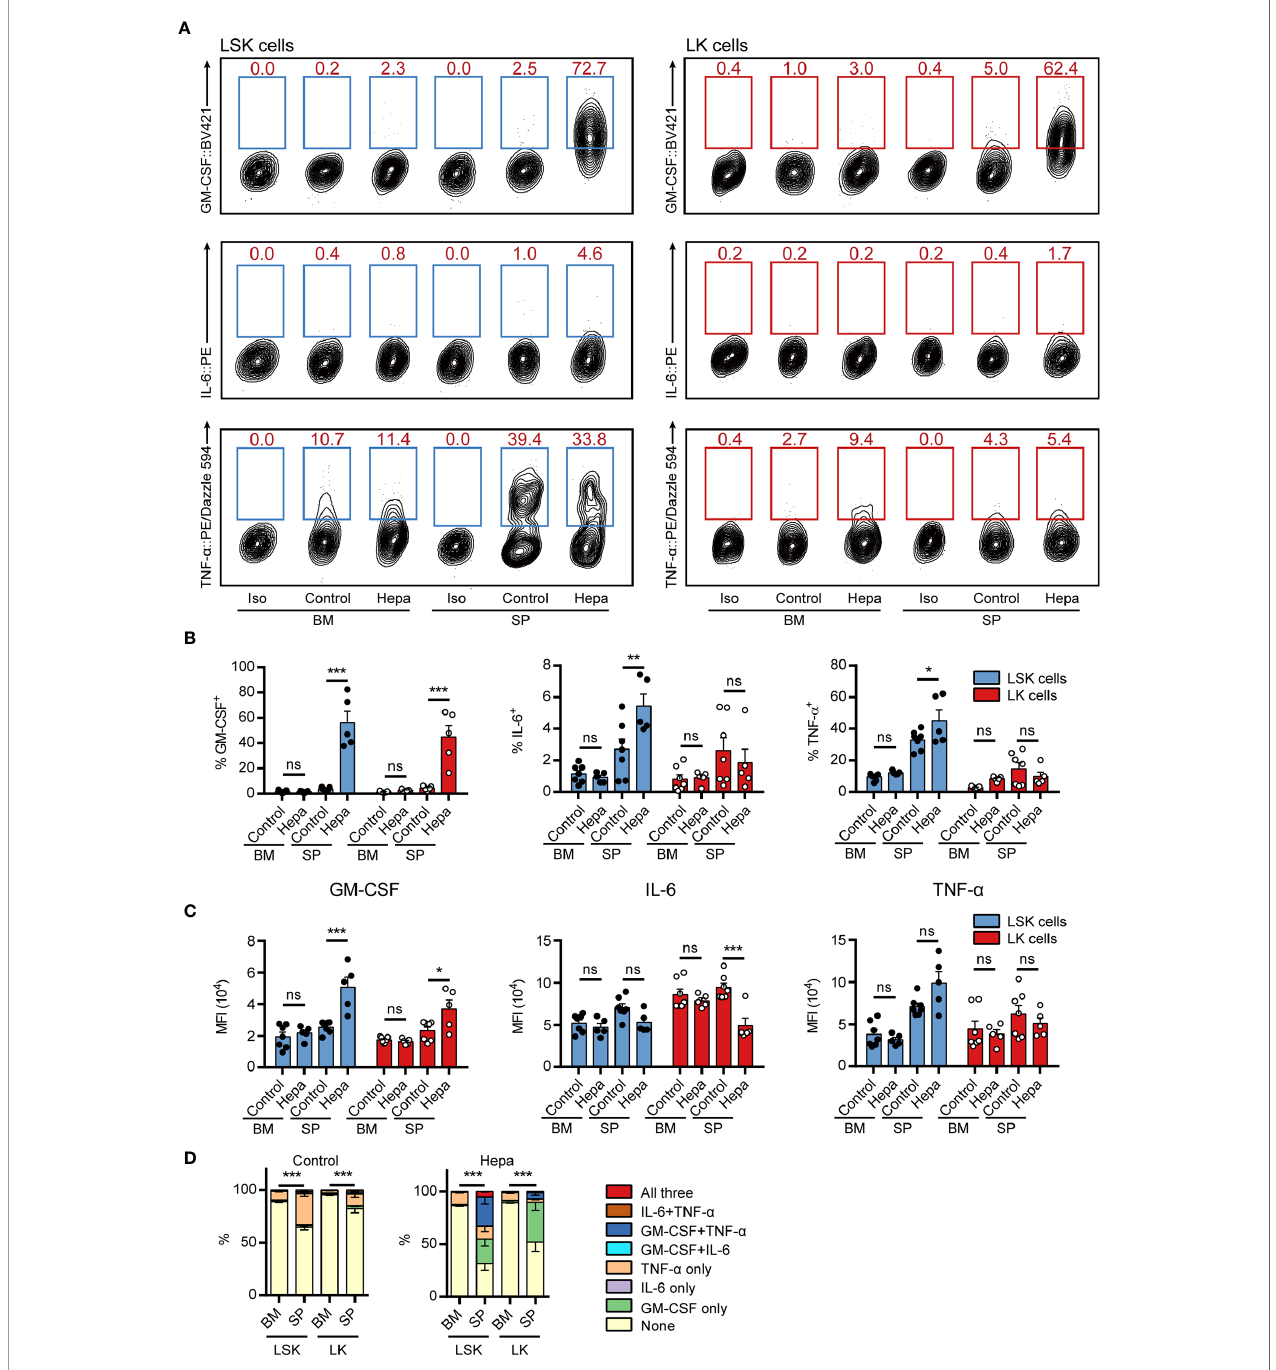
FIGURE 3 | Measuring intracellular cytokine levels in freshly isolated HSPCs from hepatoma-bearing mice with restimulation II. (A) Representative fl ow cytometric analysis of intracellular GM-CSF, IL-6 and TNF- a in freshly isolated LSK cells (left) and LK cells (right) from the BM and spleen of control or Hepa mice. The numbers in the fl ow cytometry plots indicate the proportions of gated cells. The data refer to a typical experiment out of three that generated similar results. Iso, isotype antibody control. (B) The percentages of GM-CSF + , IL-6 + , and TNF- a + cells in LSK and LK cells ( n = 5 – 7 per group). * P < 0.05, ** P < 0.01, *** P < 0.001; ns, not signi fi cant, by 2-way ANOVA followed by Tukey ’ s test. (C) The median fl uorescence intensity (MFI) of GM-CSF, IL-6, and TNF- a in the corresponding cytokine- positive cells ( n = 5 – 7 per group). Data are shown as the mean ± SEM. * P < 0.05, ** P < 0.01, *** P < 0.001; ns, not signi fi cant, by 2-way ANOVA followed by Tukey ’ s test. (D) Polyfunctionality of LSK and LK cells from the BM and spleen of control or Hepa mice ( n = 5 – 7 per group). Data are shown as the mean ± SEM. *** P < 0.001, by a two-way ANOVA with